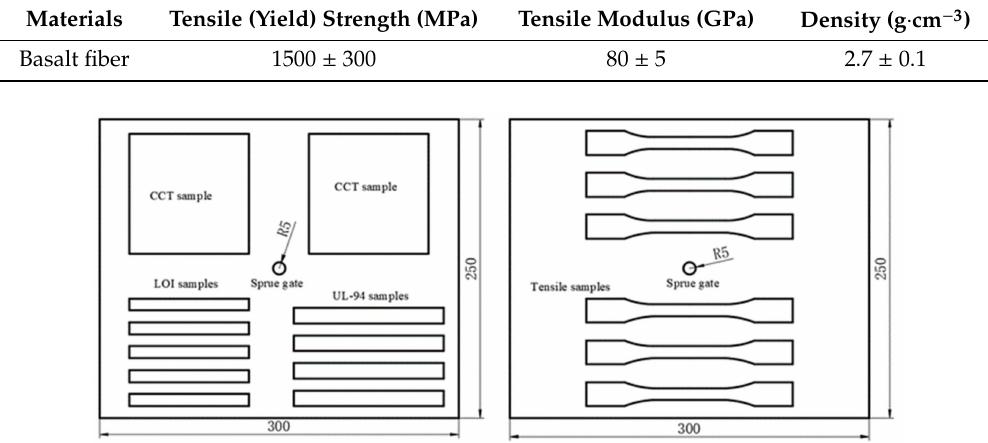
Table 1. Material properties of basalt fiber and polypropylene.